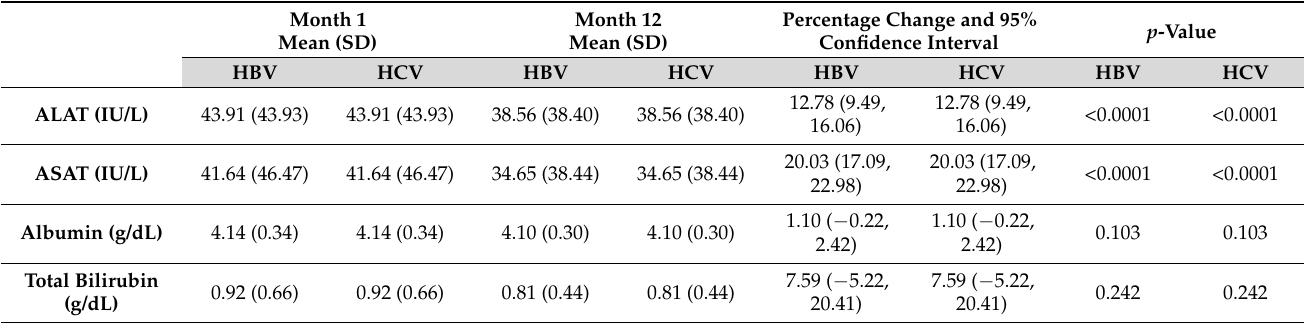
Table 6. Mean liver toxicity measurements and percentage change between 1 and 12 months in both HIV mono-infected and HIV/HBV and HIV/HCV co-infected patients.